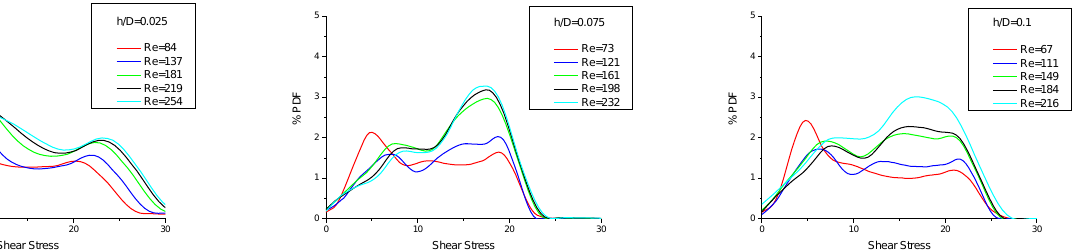
Figure 5. Percent probability density function of the dimensionless local time-averaged shear stresses on the membrane surface for the cases examined in this work. Shear stresses are normalized with the quantity μU/D.